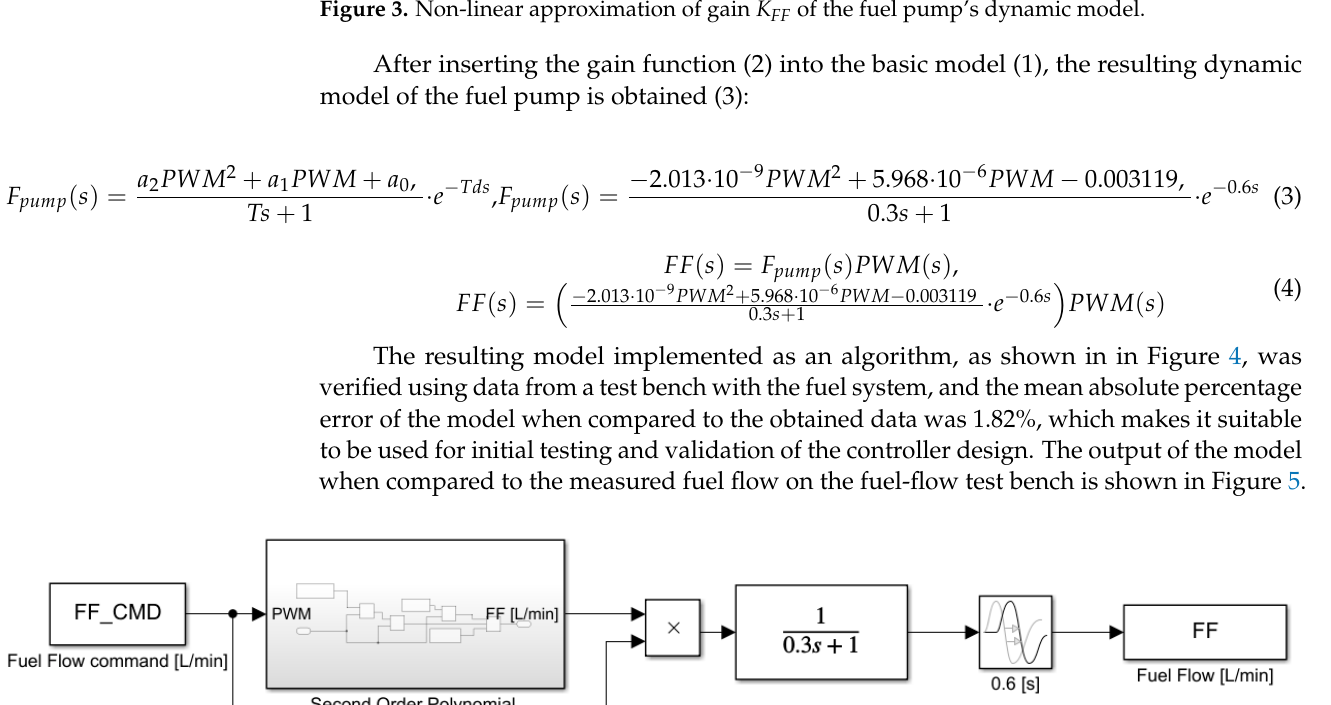
Figure 4. The implemented structure of the dynamic model of the fuel pump with non ‐ linear ap ‐ proximation.